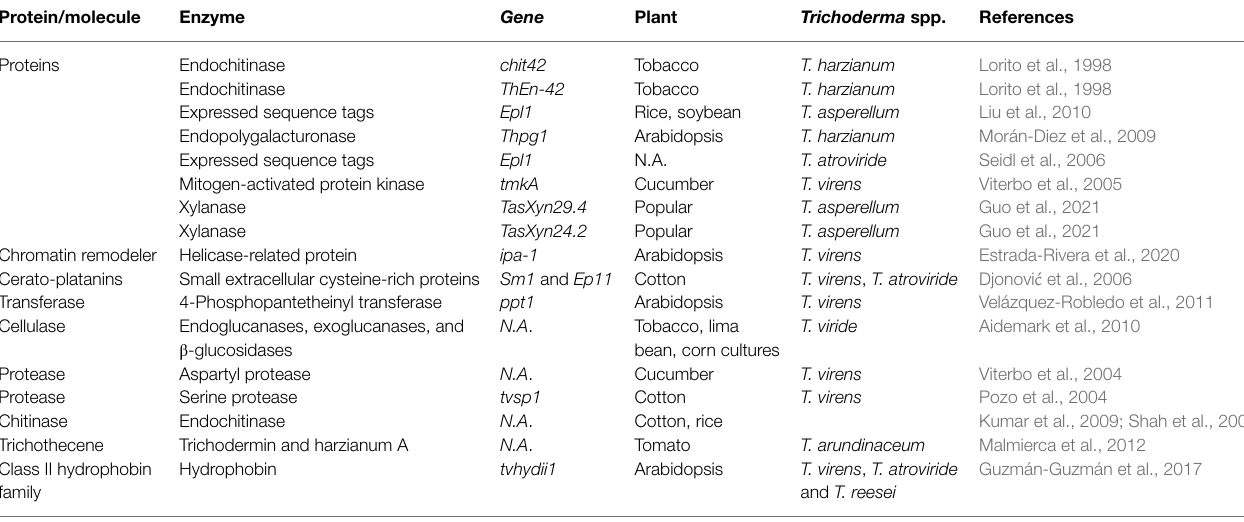
TABLE 5 | Role of Trichoderma spp. genes which act as elicitors in resistance induction in different plants against R. solani . Protein/molecule Enzyme